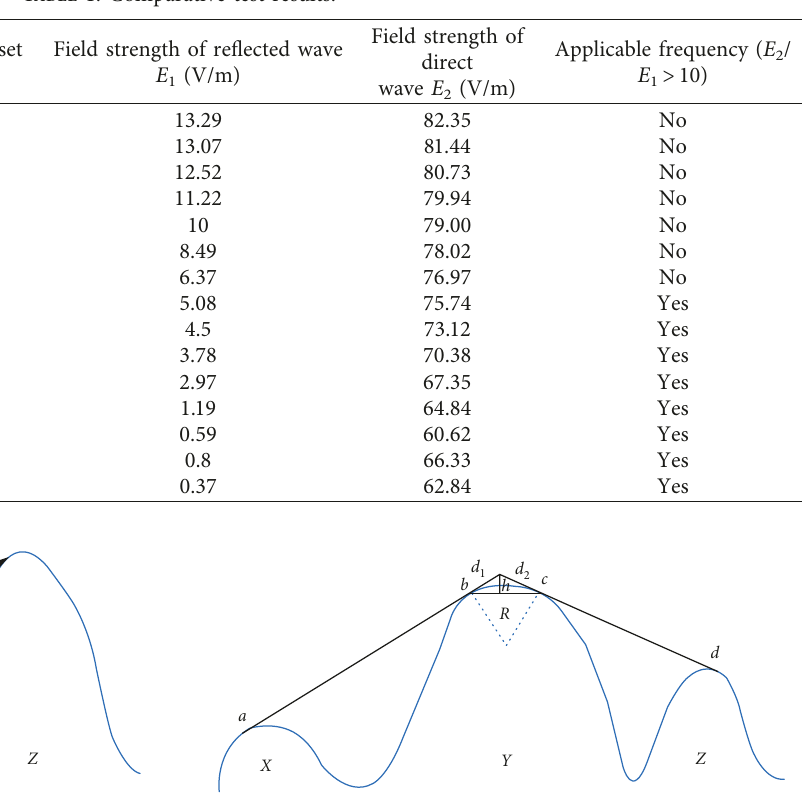
Figure 10: The experimental diagram of the applicable frequency of the link-peak diffraction model. (a) The first set of experiments. (b) The second set of experiments. Table 1: Comparative test results.